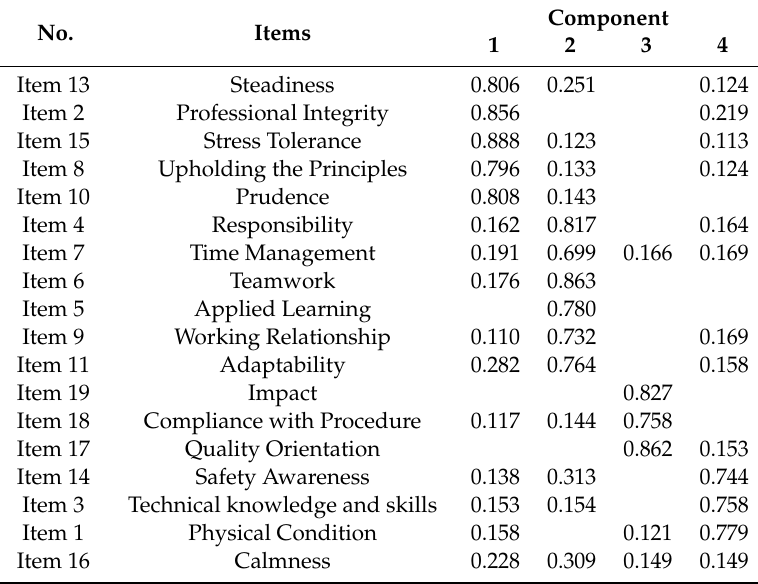
Table 6. Factor loading matrix after varimax